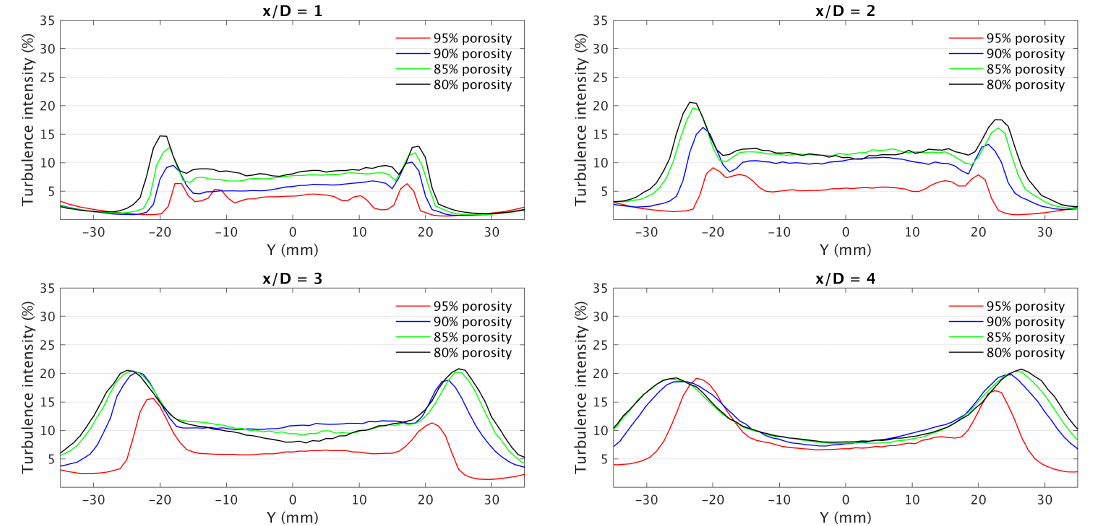
Figure 11. Turbulence intensity graph for cylinders